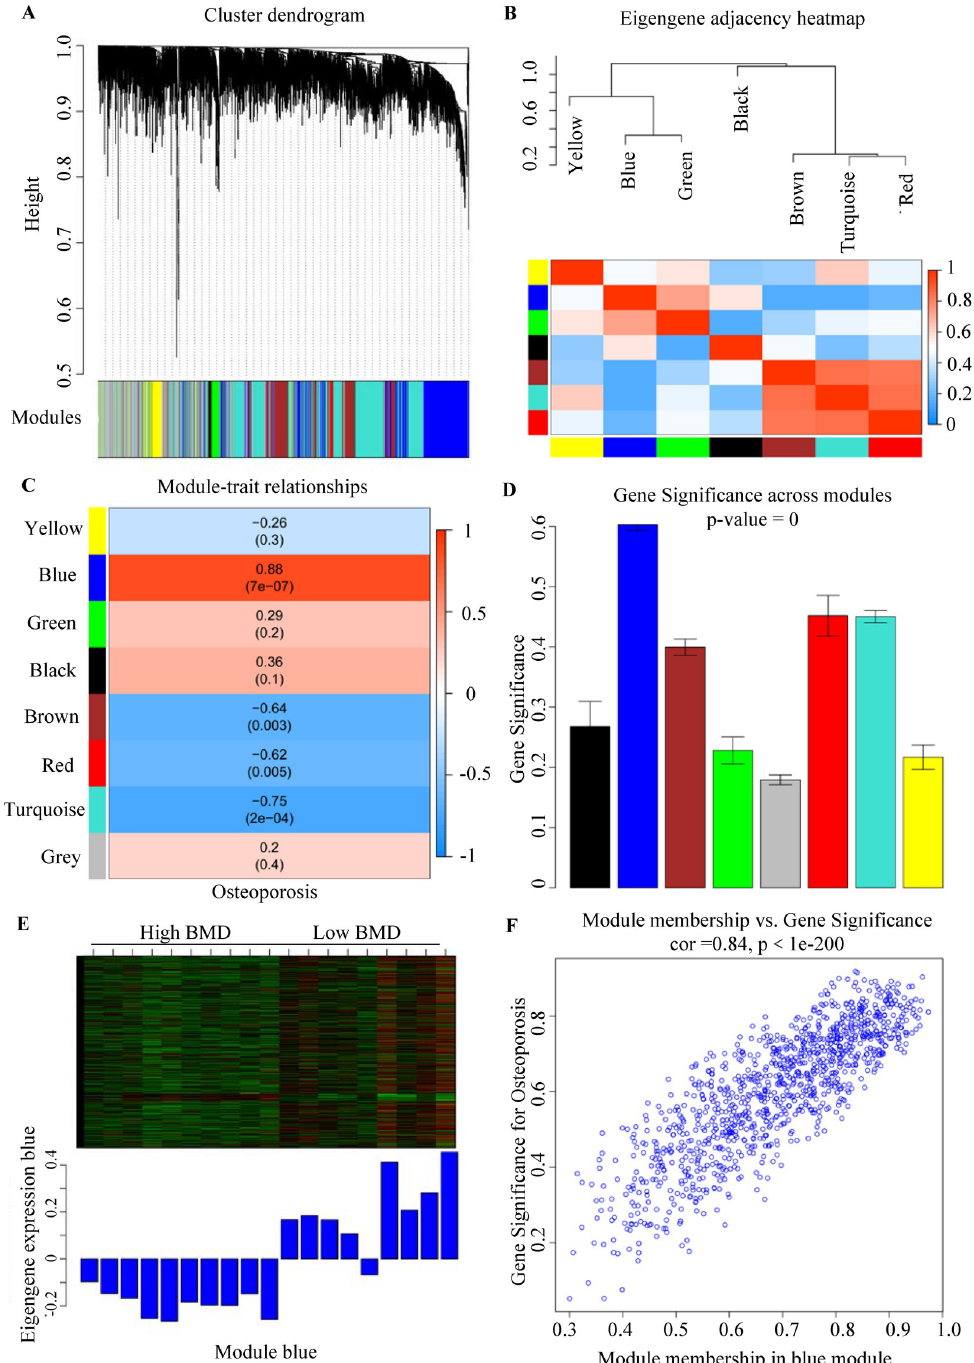
Fig 3. Identification of significant gene modules correlated with osteoporosis. (A) Cluster dendrogram of representative gene modules. (B) Clustering heatmap of module eigengenes. (C) Relationships of module eigengenes and osteoporosis. The number in the square at the top of each row is the correlation coefficient, and P -values are shown below. (D) Gene significance across modules. (E) Heatmap and bar graph of the eigengenes in module blue. (F) Scatterplot of gene significance vs. module membership in the blue